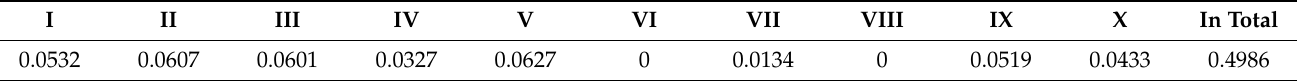
Table A3. Results by items (Product Development